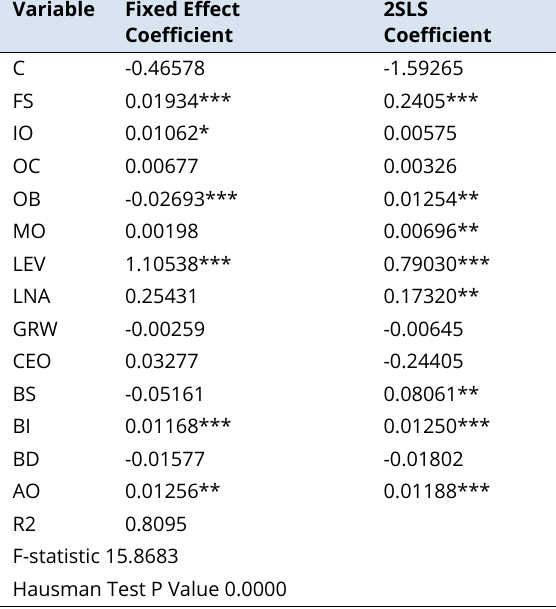
Fixed effect and 2SLS Regression of Foreign Shareholdings and Tobin’s